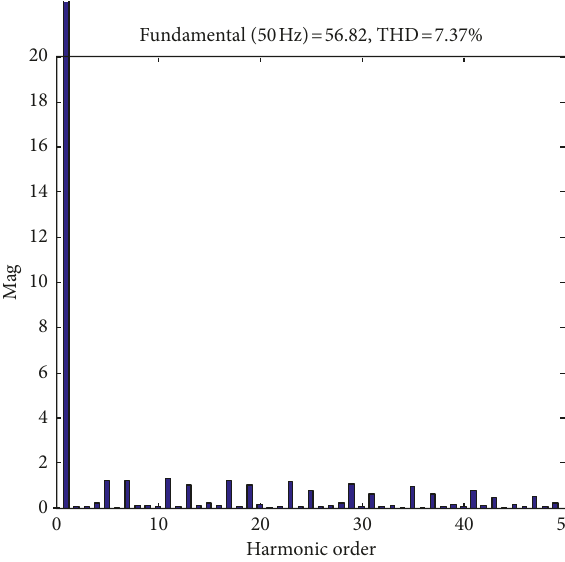
Figure 14: FFT analysis of source current using PI controller.